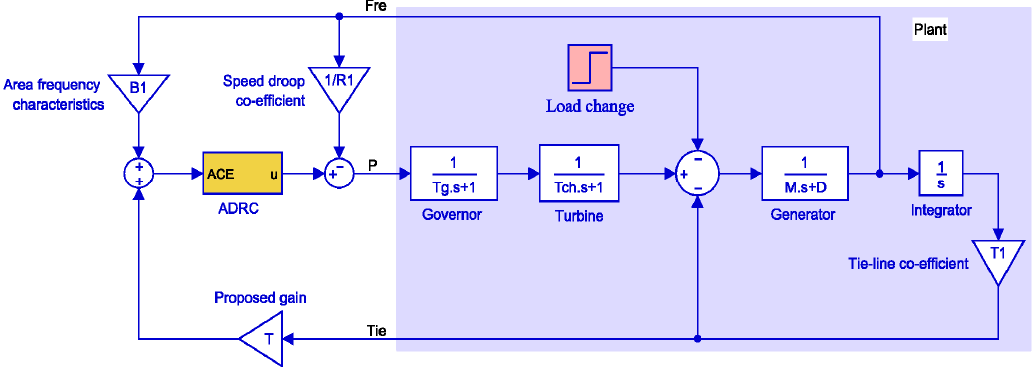
Figure 3. Proposed ADRC-based LFC model for generator electrical proximity to the point of impact.